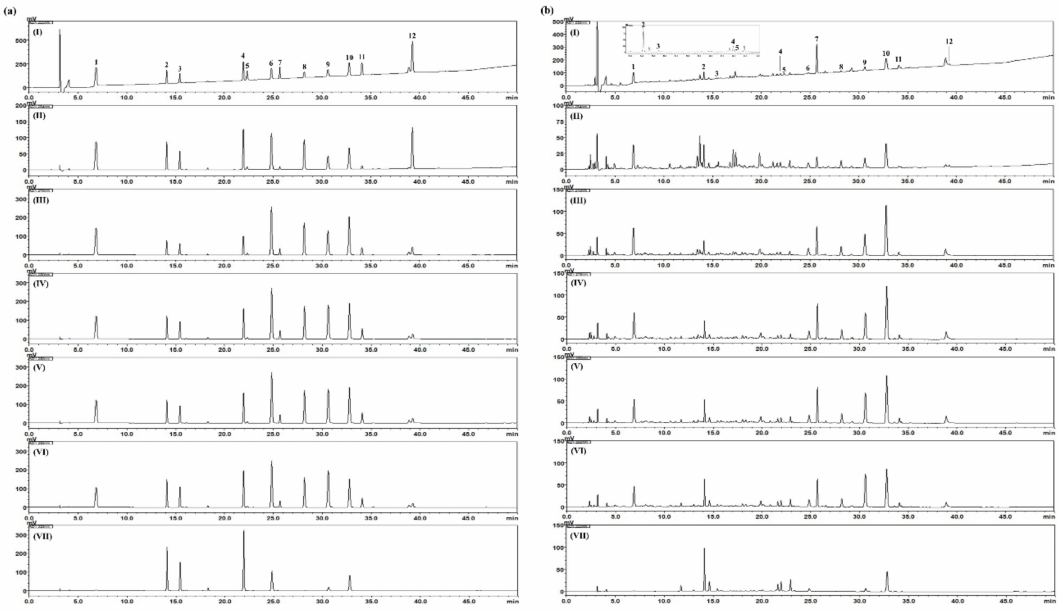
Figure 3. HPLC chromatograms of standard solutions ( a ) and NI-01 sample ( b ) at 225 nm (I), 254 nm (II), 270 nm (III), 275 nm (IV), 280 nm (V), 285 nM (VI), and 325 nm (VII). 1: gallic acid, 2: chlorogenic acid, 3: ca ff eic acid, 4: isochlorogenic acid A, 5: benzoic acid, 6: coumarin, 7: arctiin, 8: cinnamic acid, 9: cinnamaldehyde, 10: paeonol, 11: arctigenin, 12: schisandrin. Table 5. The amount of 12 marker compounds in the freeze-dried NI-01 sample (n = 3). Batch Compound